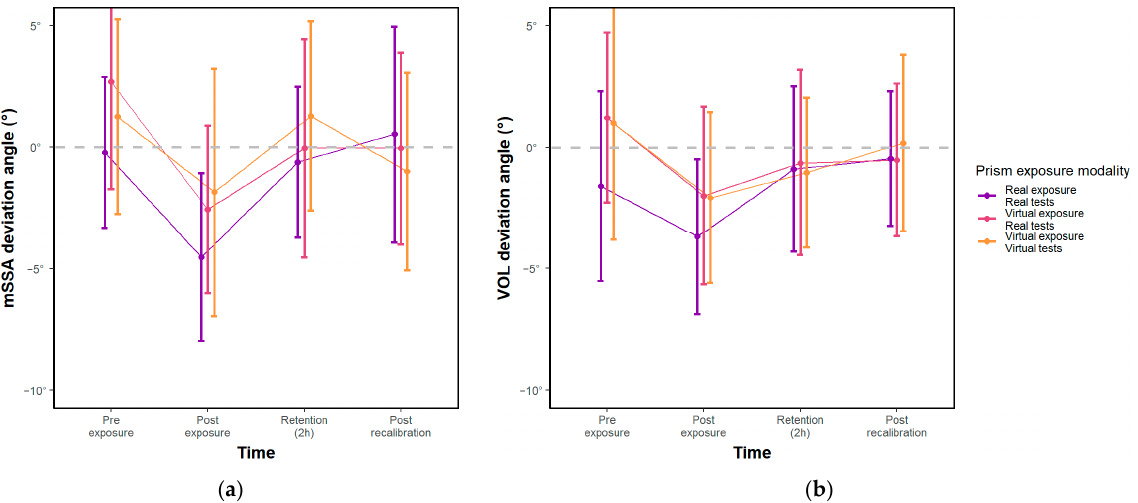
Figure 5. ( a ) Deviation evaluated in mSSA according to the 3 modalities and the 4 times tested; ( b ) Deviations evaluated in VOL. Dots correspond to means, vertical bars to standard deviations.